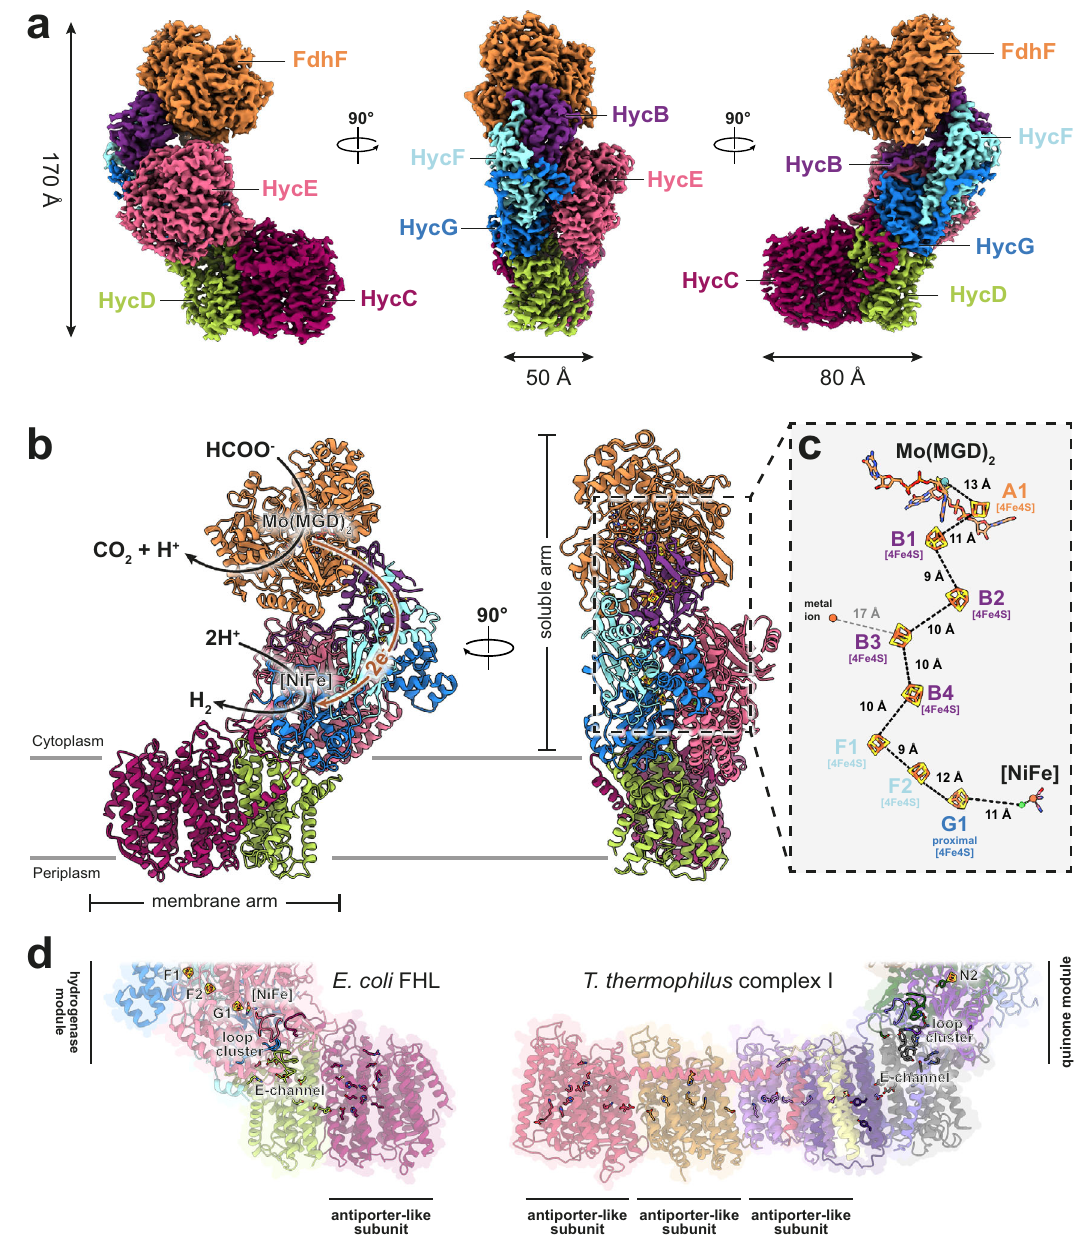
Fig. 1 | Overall architecture and atomic model of E. coli FHL. a Composite cryo- EM map of aerobically isolated FHL segmented and colored by subunit. Except where otherwise indicated, subunit coloring is consistent throughout the manu- script. b AtomicmodelofaerobicallyisolatedFHL.Formateoxidationoccursatthe Mo(MGD) 2 site in FdhF and electrons are transferred to the [NiFe] hydrogenase HycE, driving proton reduction to H 2 . The soluble arm is connected to the mem- brane arm via subunit HycD. c An iron-sulfur cluster relay with distances less than 14Å connects the active sites. The [4Fe4S] clusters are labeled and colored